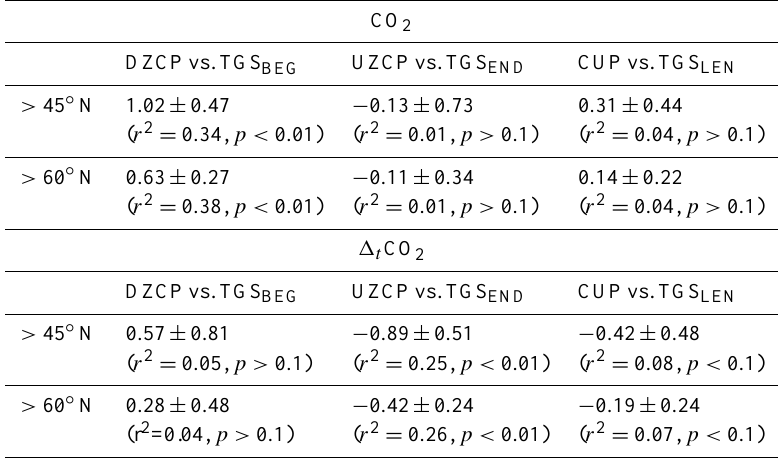
Table E2. Linear regression coefficients that describe the relationship between changes in CO 2 , (cid:49) t CO 2 , and temperature phase metrics at different latitude bands in the high northern latitudes